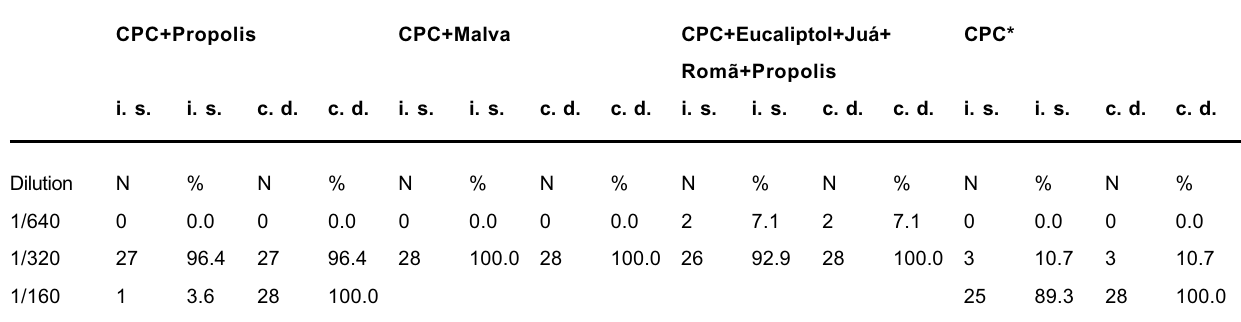
TABLE 2- Percentage of S. aureus strains inhibited (from a total of 28 strains) by each dilution of the tested mouthwashes